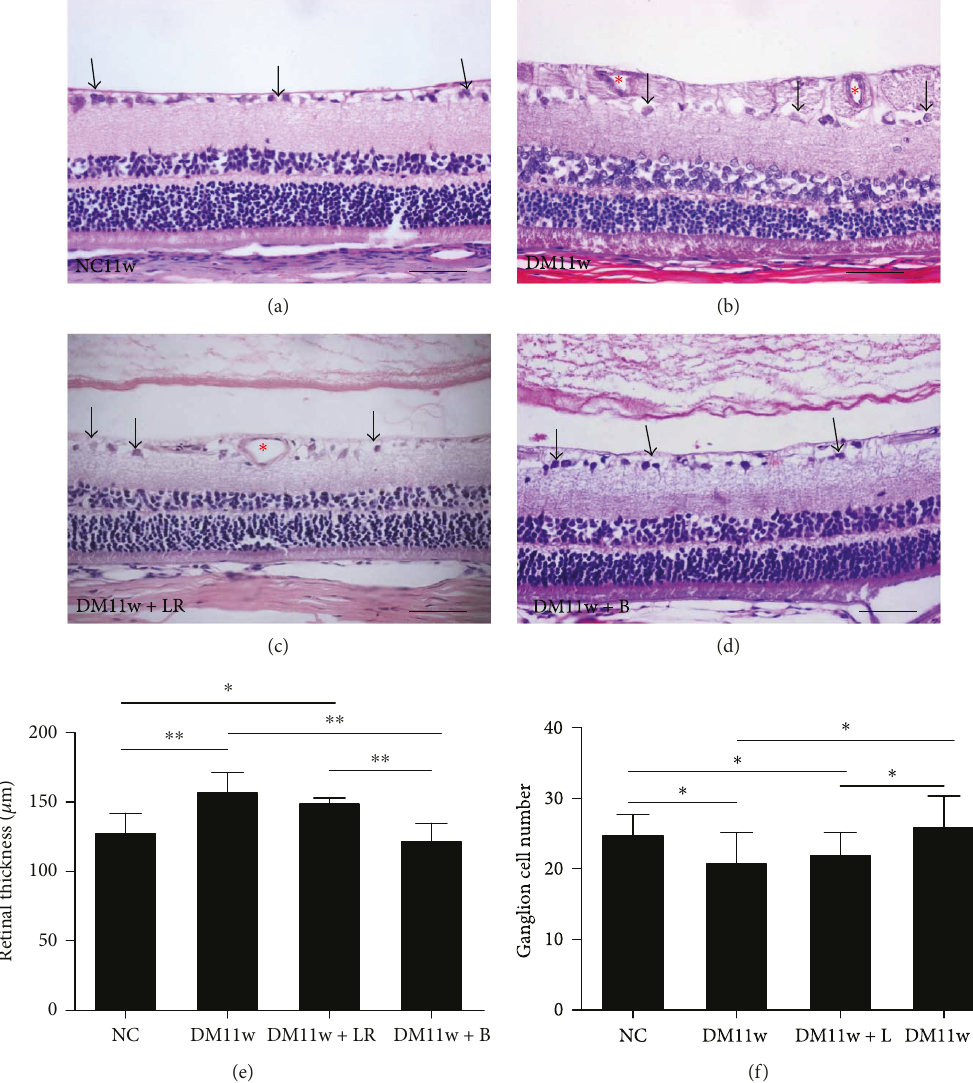
Figure 6: H&E staining of the retina in the NC11w, DM11w, DM11w+LR, and DM11w+B groups. (a – d) Note the cellular morphological changes (single arrow) in the DM11w and DM11w+LR groups compared with the NC11w and DM11w+B groups. Blood vessels were dilated in diabetic retina notably at the DM11w and DM11w+ LR (asterisk). (e, f) Quanti fi cation of retinal thickness and ganglion cell number each group. Bar=50 μ m. ∗ p < 0 05 and ∗∗ p < 0 01